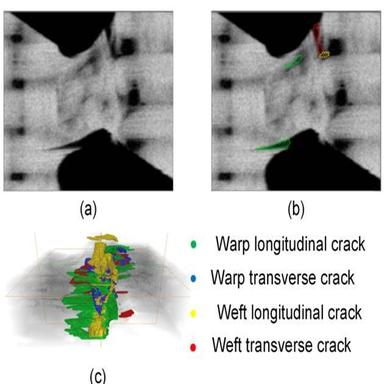
Crack marking and 3D visualization: (a) Shear area; (b) Cracks marking; (c) Cracks distribution.